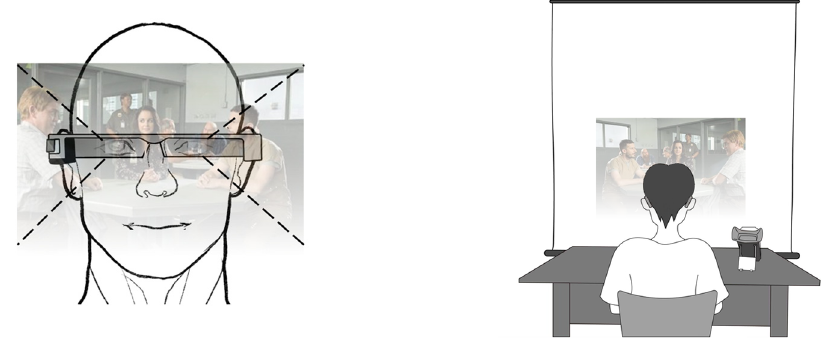
Figure 1. Participants executing a visual task using OHMD in this study.